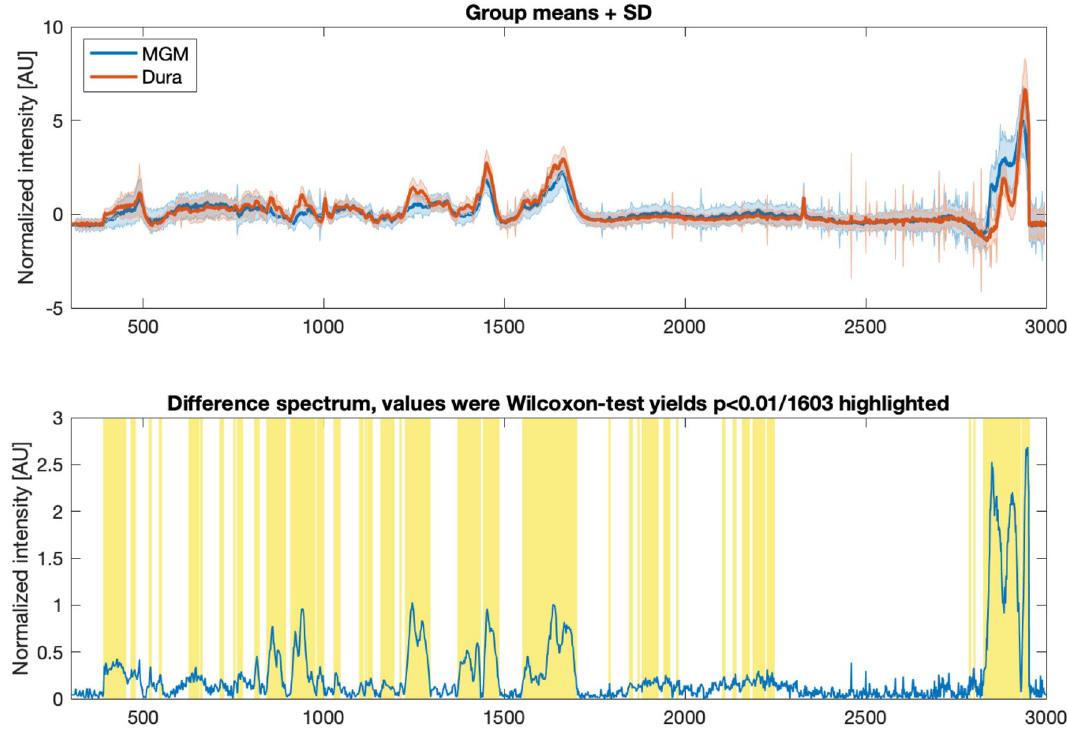
Figure 4. Top: Average spectra of all normalized (z-score normalized) meningioma and dura mater measurements; Bottom: Absolute difference spectrum of the previously plotted average spectra.